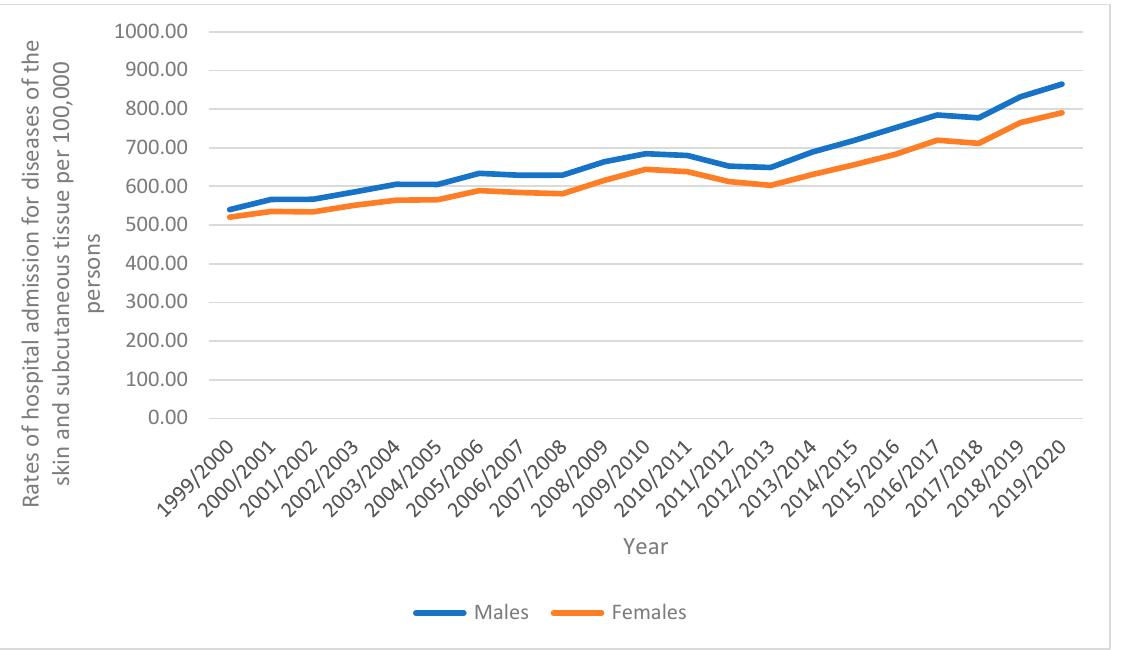
Figure 3. Rates of hospital admission stratified by sex. 3.1. Diseases of the Skin and Subcutaneous Tissue Admission Rate by Sex Most hospital admission rates for males were greater than for females. This comprises skin and subcutaneous tissue infections, papulosquamous disorders, bullous disorders, radiation-related skin and subcutaneous tissue disorders, and disorders of skin appendages (Figure 4). However, compared to males, females had greater hospital admission rates for dermatitis and eczema, urticaria and erythema, and other conditions affecting the skin and subcutaneous tissue (Figure 4).